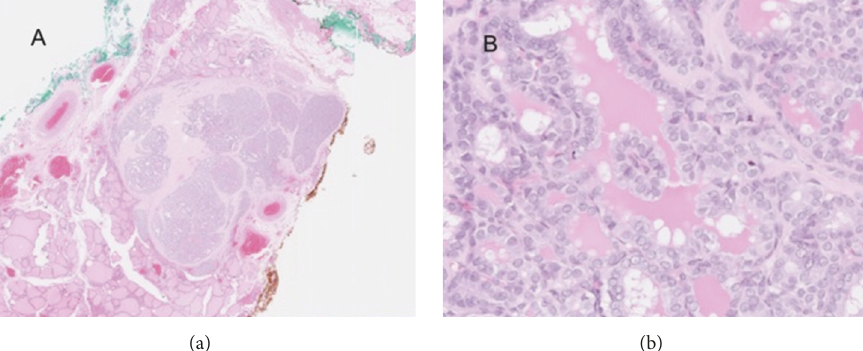
Figure2:(a)Wellcircumscribednodulecomposedofpapillarythyroidcarcinomawithsolid,follicular,andpapillaryarchitecturesurrounded by fibrosis. (b). Areas with papillary architecture with cytologically enlarged nuclei with grooves and open